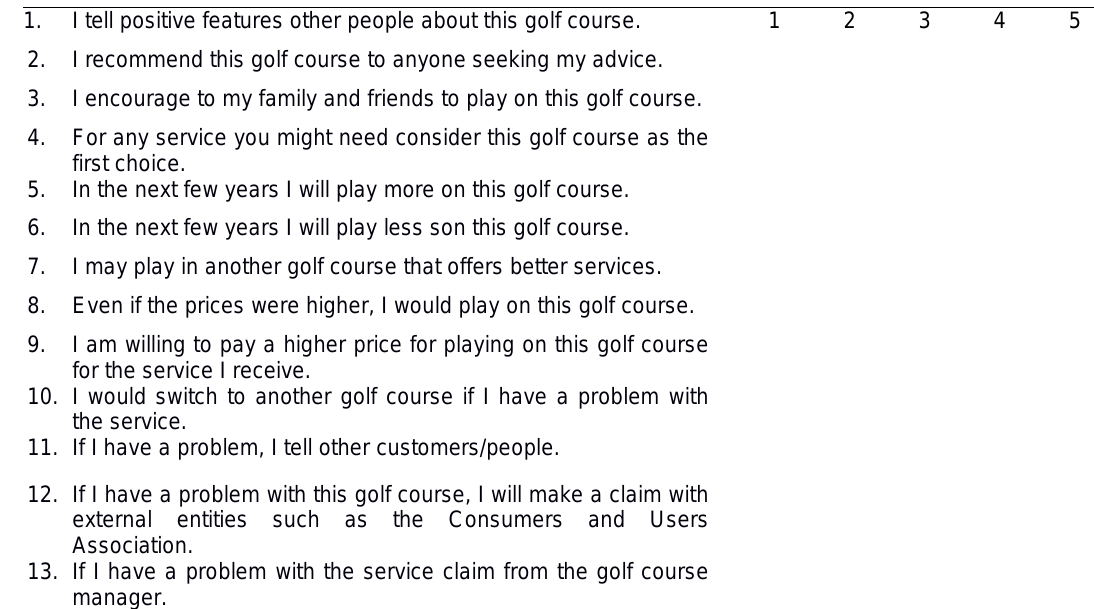
Table A.1. Questionnaire adapted of future behavioural intentions (Loyalty) of the golf courses (Pradas,